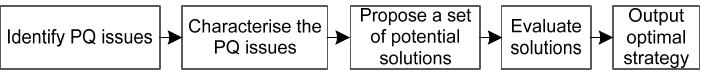
Figure 1. Illustration of power quality (PQ) optimization/mitigation [76].